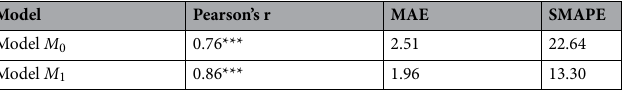
Table 1. Seasonal Auto Regressive Integrated Moving Average (SARIMA) models of predicting normalized number of mental health consultations in the test dataset (year 2016 data) (* p < 0.01 , ** p < 0.001 , *** p < 0.0001 ). Dependent overlapping correlation: t = − 2.07**.